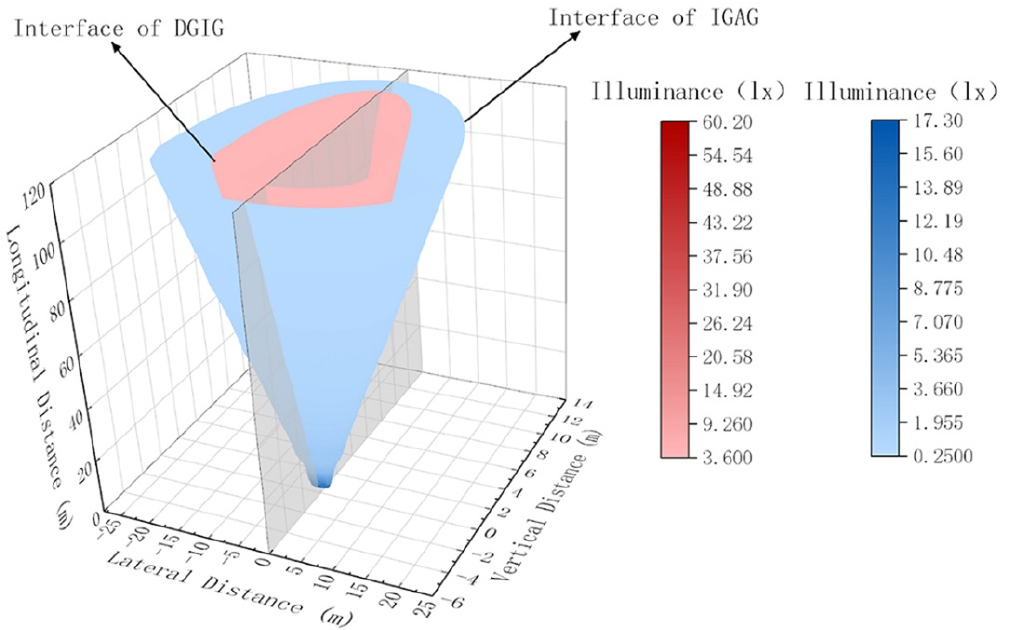
Figure 14. Spatial distribution of DGIG and IGAG at different longitudinal distances within 120